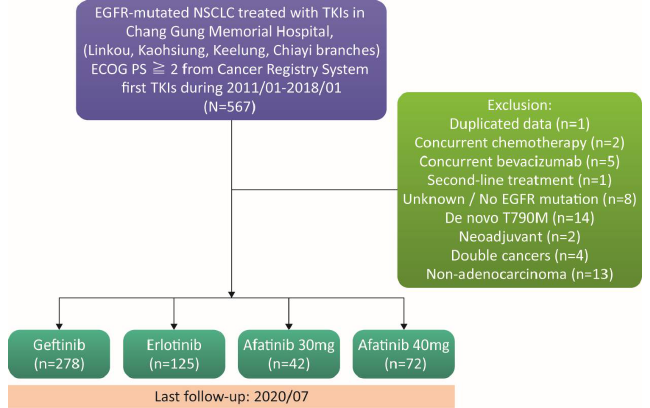
Figure 1. A flowchart showing patient enrollment and follow-up.